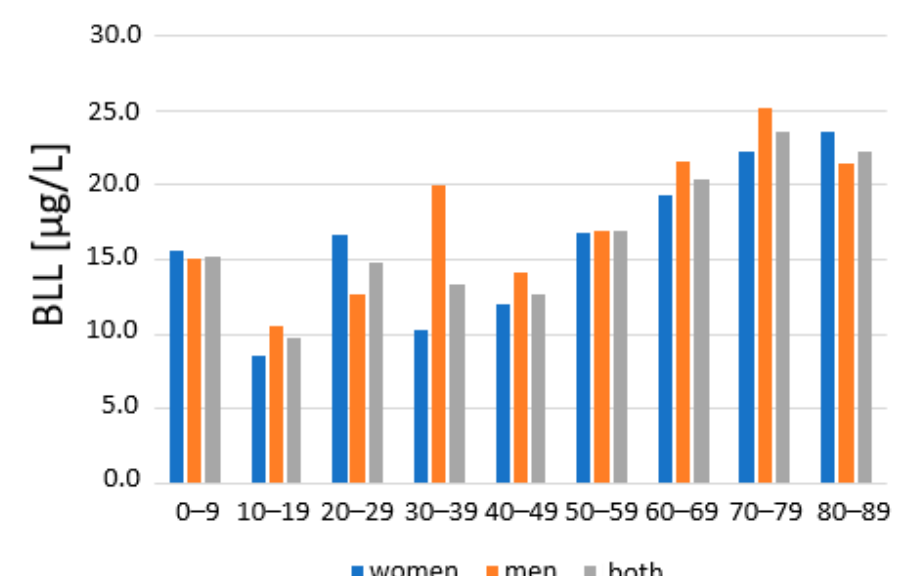
Figure 3. Mean BLL depending on sex and age of the volunteers.